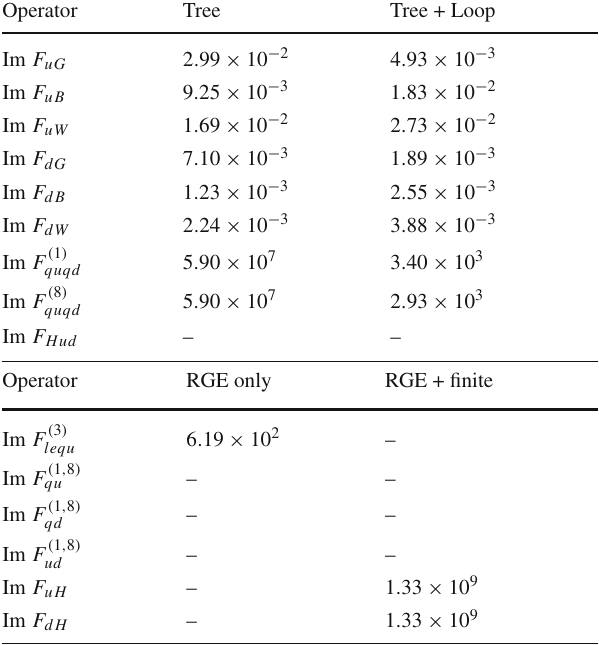
Table 12 Upper bounds on the Wilson coefficients assuming (cid:2) = 5 TeV and a U ( 3 ) 5 flavor symmetry, keeping terms up to O ( y 2 The dipoles can again enter at tree level while the 4-fermion operators all only contribute via RG running. The operators O and O Hud are forbidden at the considered order in the spurions. The bounds on all bosonic operators are obviously the same as above Operator